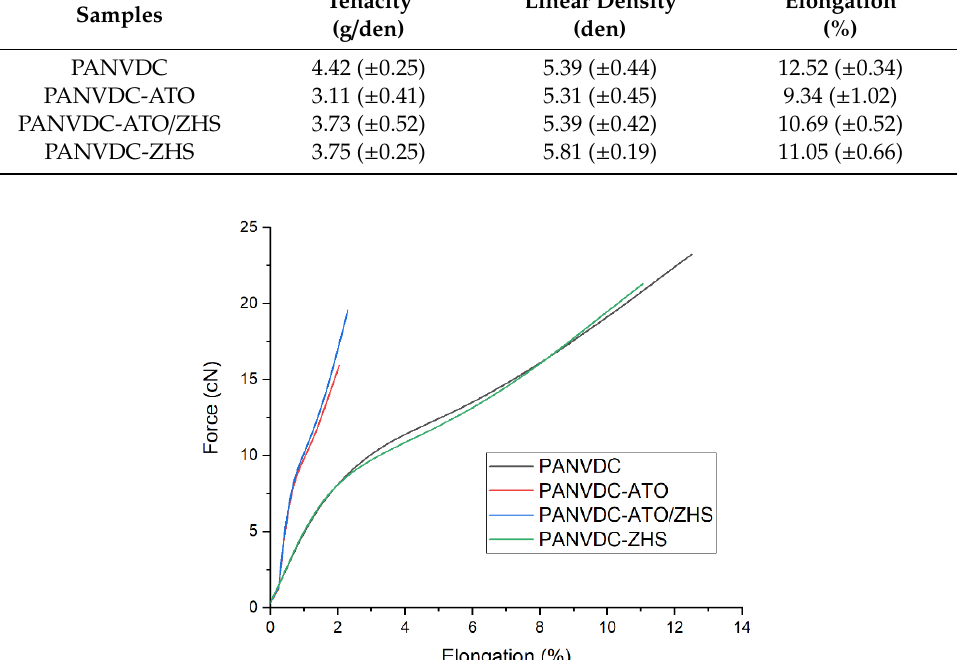
Table 8. Mechanical properties of the PANVDC fibers with the flame retardants. Samples